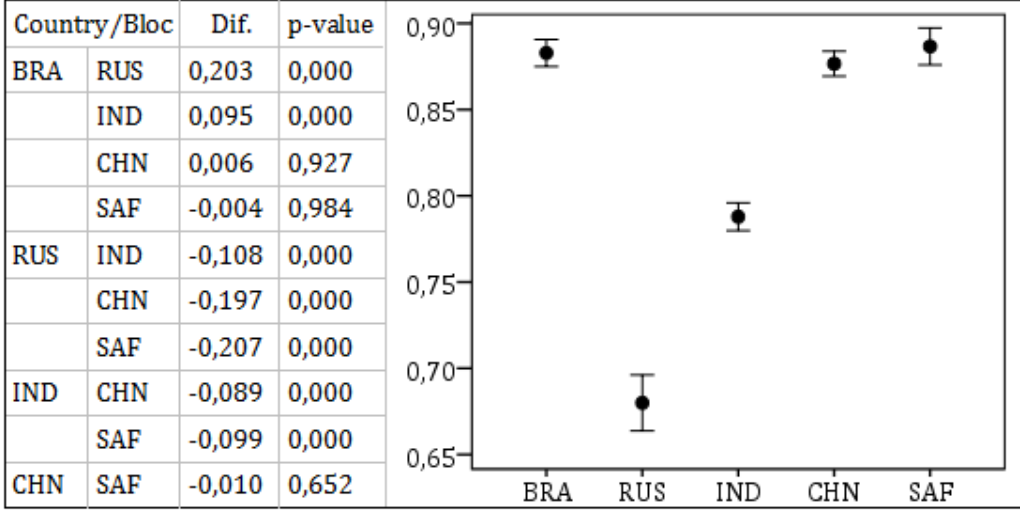
Source: Voeten (2013) – United Nations General Assembly Voting